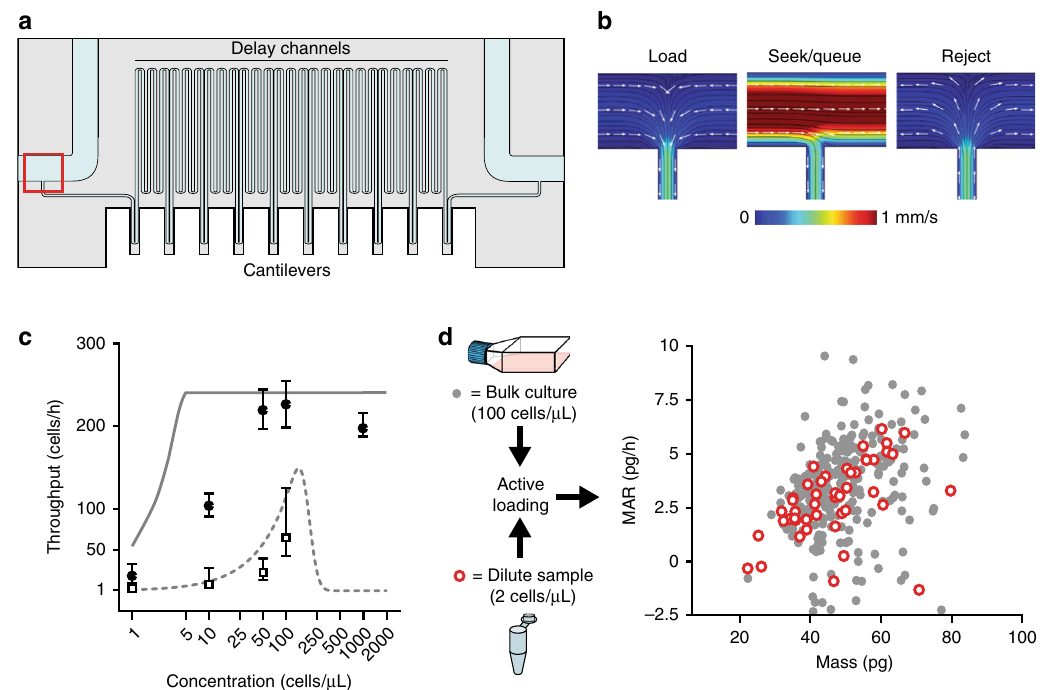
Fig. 2 Active loading enables single-cell growth measurements of dilute samples. a Schematic of the serial suspended microchannel resonator (sSMR). Sampling channels on either side of the device (100 μ m wide and 30 μ m deep) are each accessed via two ports with independent pressure control to achieve the fl uidic states presented in b . These sample channels are connected with a serpentine channel (50 cm long, 20 μ m wide, and 25 μ m high) with 10 – 12 SMR mass sensors spaced evenly along its length. Mass accumulation rate (MAR) is calculated by taking the slope of the linear least squares fi t of mass measurements collected from individual SMRs as a function of time for each single-cell trajectory. b COMSOL models demonstrating the fl ow characteristics of the four different fl uidic states presented in Fig. 1a. The model shows the T-junction entrance of the sSMR, outlined with a red box in a . Flow patterns were modeled using the volumetric fl ow rates described in Supplementary Note 4 to recapitulate experimental conditions. c Comparison of theoretical throughput limits (solid and dashed lines for active and passive loading, respectively) with experimental results (solid points and open squares for active and passive loading, respectively) for samples with 1, 10, 50, 100, and 1000 L1210 cells μ L − 1 ( n = 15, 105, 143, 149, and 83 for active loading and n = 1, 8, 64, 87, and 309 for passive loading) collected with a 15 s minimum spacing. The theoretical model is based on a 15 s duty cycle (Supplementary Note 4). Measurement error bars represent the 95% CI (two-tailed t test) of loading period (s) converted to throughput (events h − 1 ). Each concentration was measured continuously for at least 20 min. The passive loading sample at 1000 cells μ L − 1 had a throughput of 747 cells h − 1 , 95% CI: 673, 832. d Dot plot of MAR vs. mass comparing L1210 cells measured from standard, growth-phase culture concentrations (100 cells μ L − 1 , gray circles, n = 426), or from samples with low concentration and low total cell count (~2 cells μ L − 1 , 100 total cells, open red circles, n =